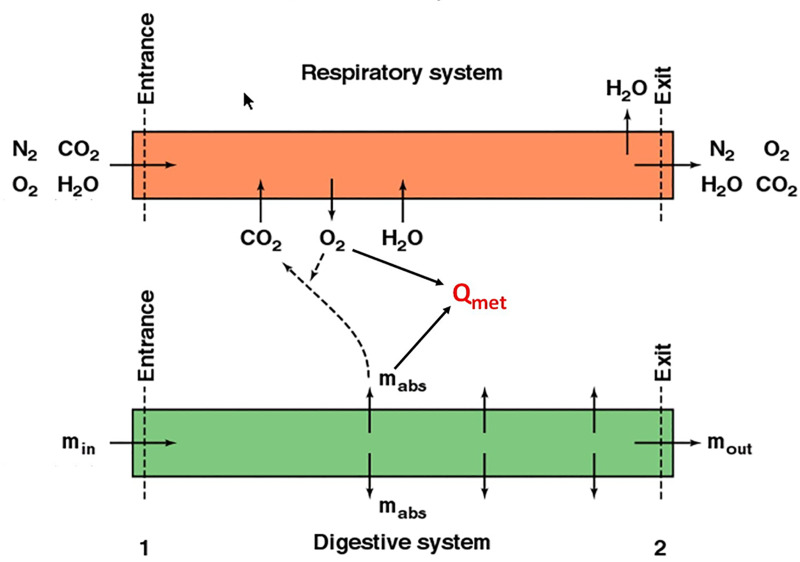
Internal mass balance models coupled to heat transfer.System diagram for the respiratory and digestive system driven by the metabolic rate, Qmet.